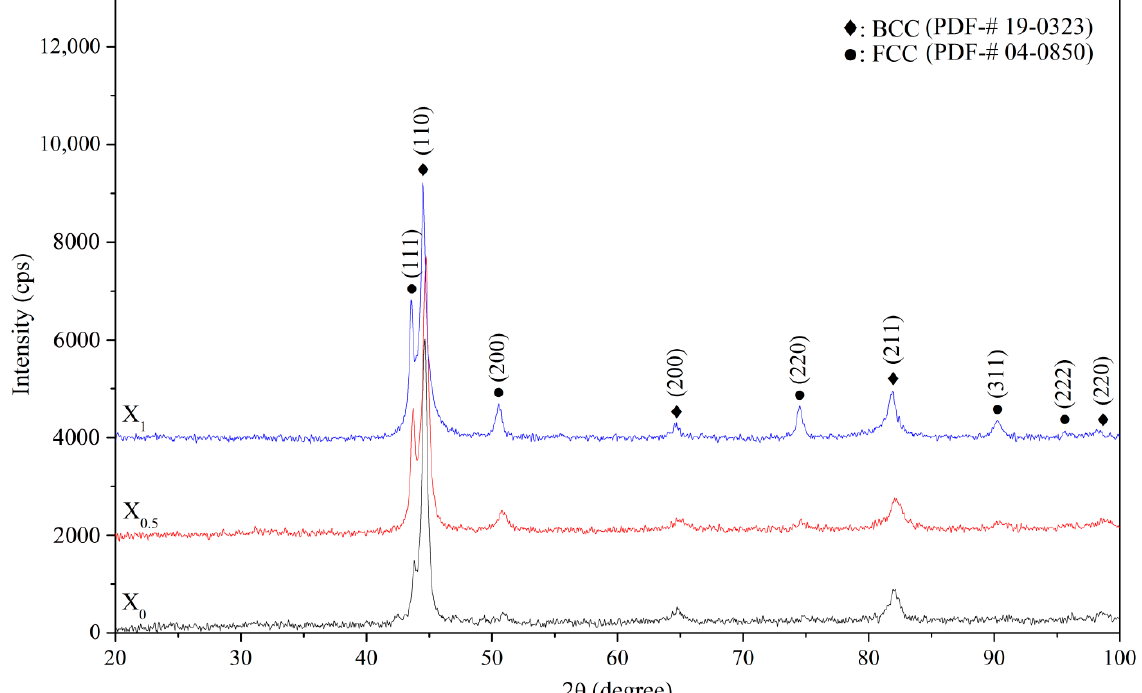
Figure 1. XRD patterns of the X 0 , X 0.5 , and X 1 as-cast